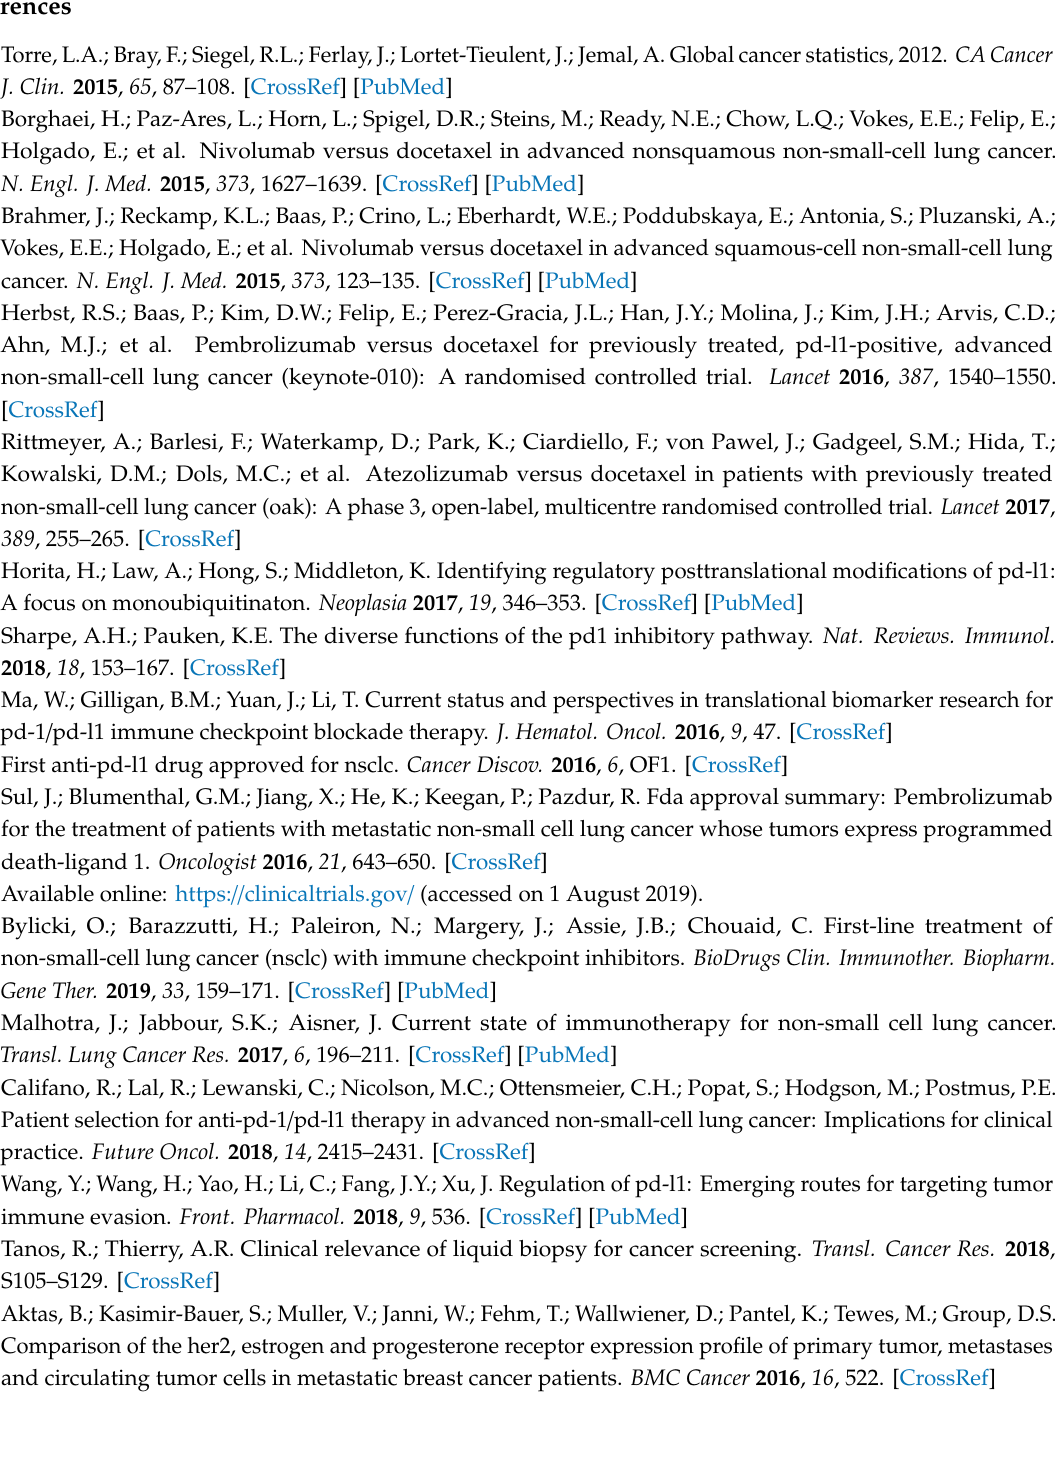
Supplementary Materials: The following are available online, Table S1: Clinical trials in lung cancer (drug: Nivolumab), Table S2: Clinical trials in lung cancer (drug: Atezolizumab), Table S3: Clinical trials in lung cancer (drug: